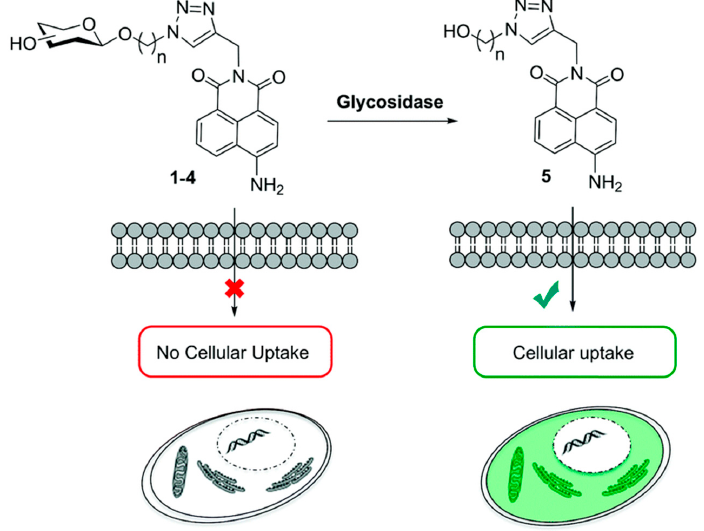
Figure 4. Glycosylated naphthalimide “probes” ( 1 – 4 ) are activated by glycosidases, resulting in the release of fluorescent probes ( 5 ), which can be endocytosed into cancer cells. Reproduced with permission from the publishers of corresponding reference [102].